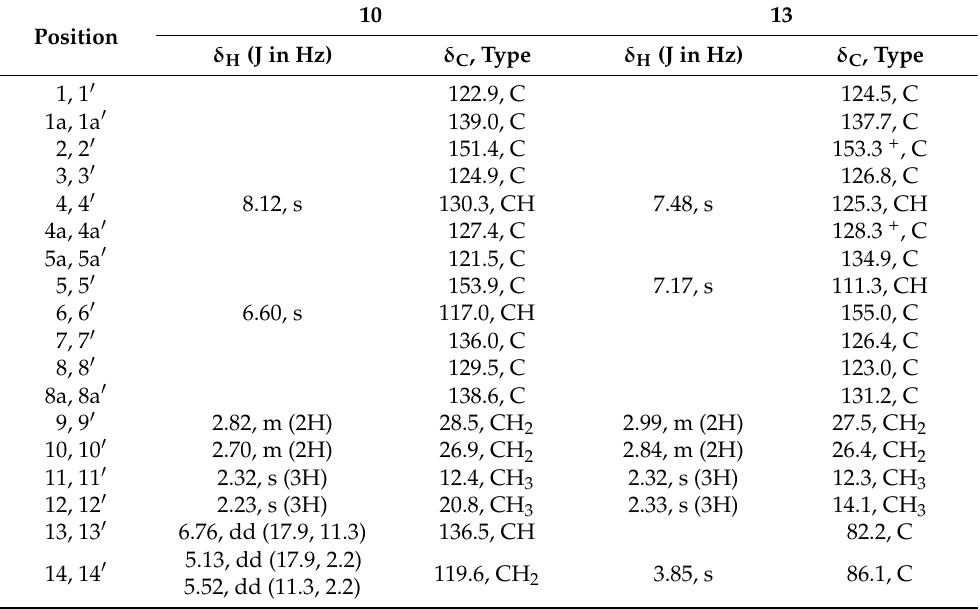
Table 4. 1 H (500 MHz) and 13 C (125 MHz) NMR data of symmetric dimers 10 and 13 in methanol- d 4